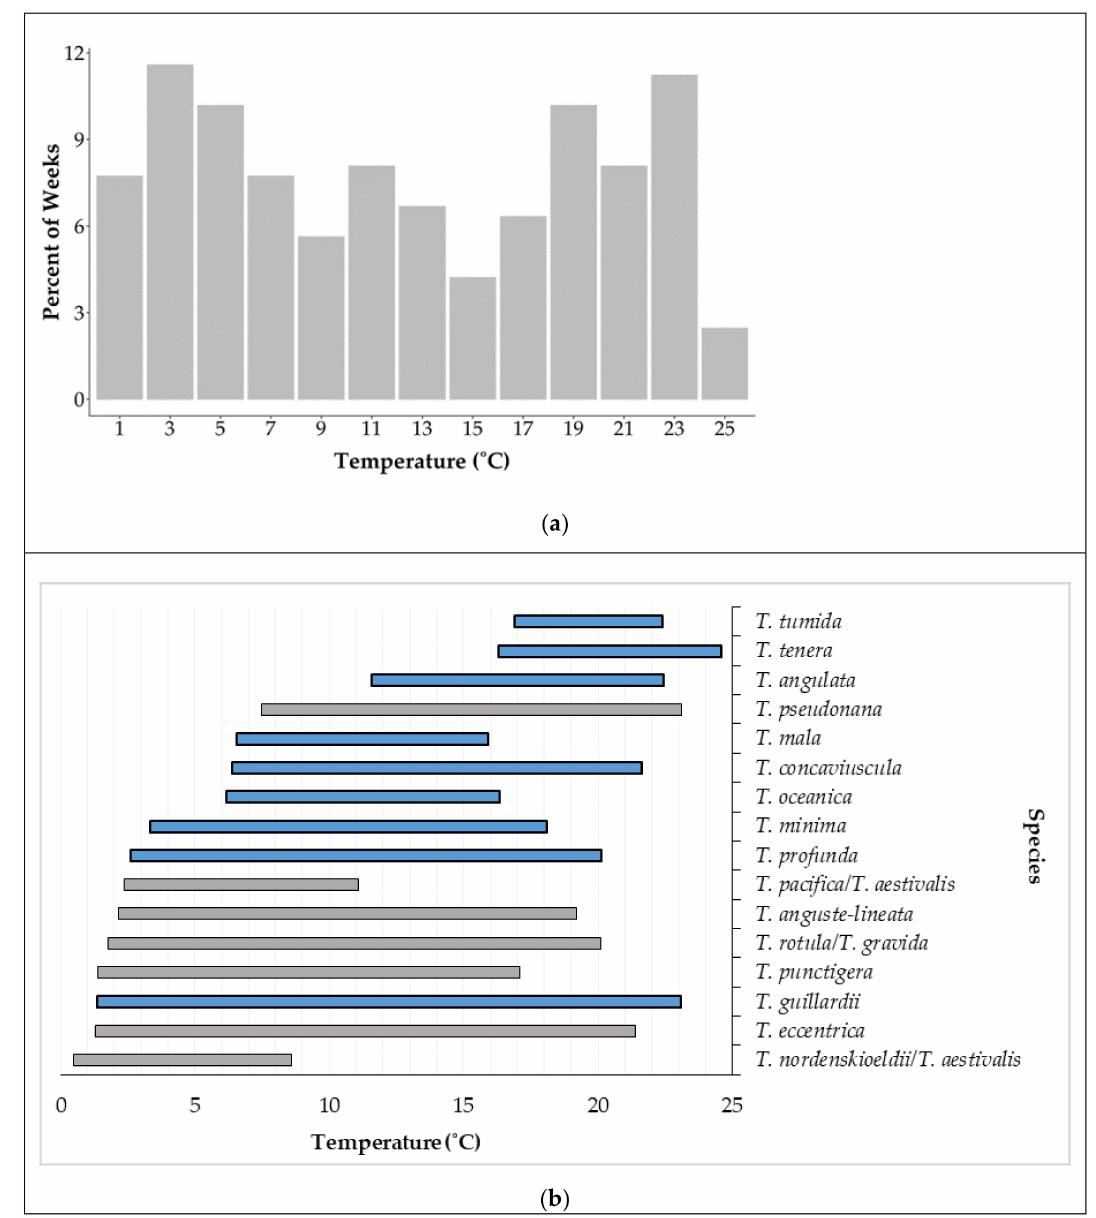
Figure 8. ( a ) Frequency distribution of surface water temperatures, in 2 ◦ C bins, measured at the Narragansett Bay Long Term Plankton Time Series site, December 2008–December 2014. Value on x -axis represents the middle of each bin (i.e., 1 ◦ C for the > 0– ≤ 2 ◦ C bin). ( b ) Observed temperature ranges for the Thalassiosira species recovered from the HTS data. Blue bars indicate newly identified species in Narragansett